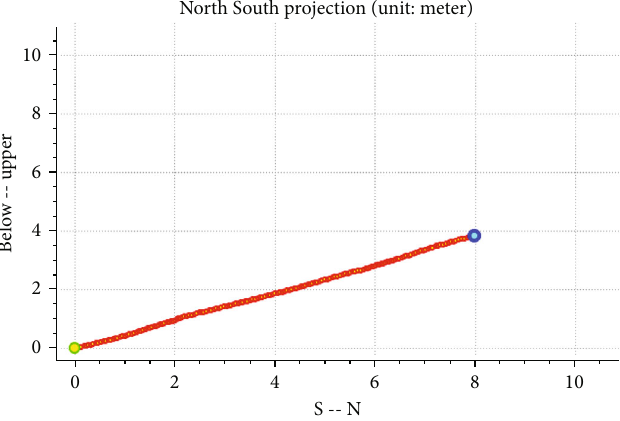
Figure 14: North-South projection of gas drainage borehole. Table 3: Gas drainage borehole trajectory measurement results (average